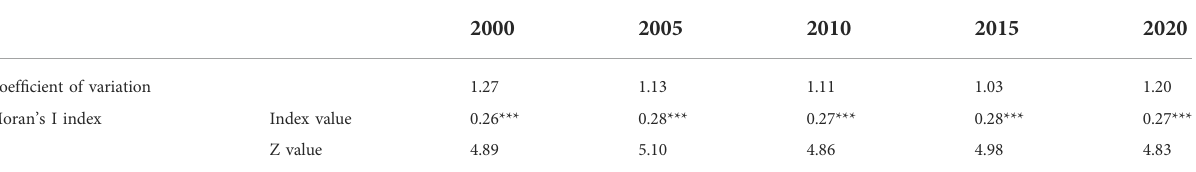
TABLE 4 Net carbon emissions global Moran ’ s I.